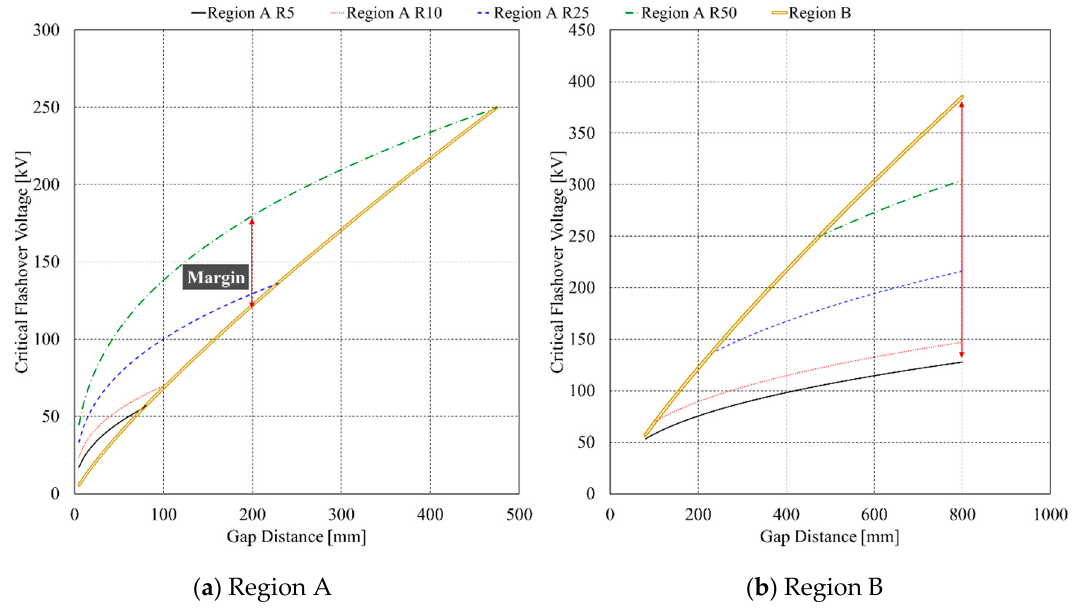
Figure 7. The trend line analysis of critical flashover voltage of switching impulse.